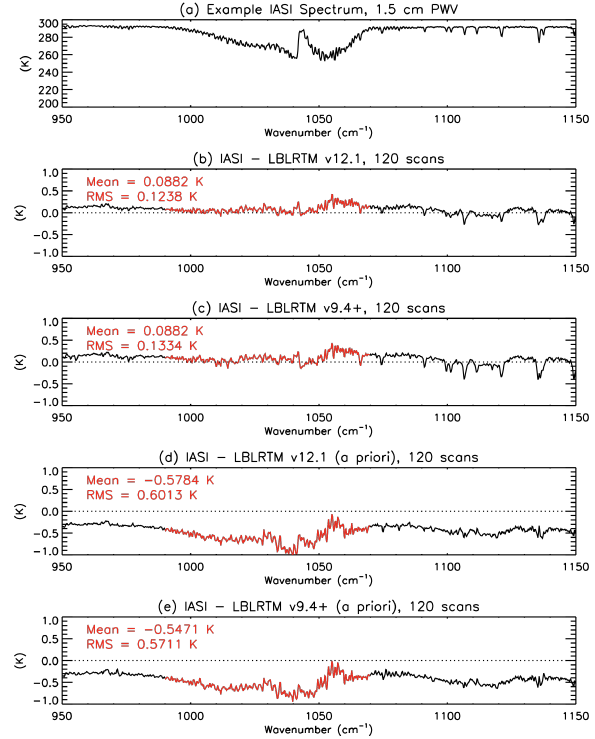
Fig. 26. (a) IASI-observed brightness temperature spectrum in the ν 3 band of O 3 for an example profile with 1.5cm PWV. (b) Mean of the final (a posteriori) brightness temperature residuals for 120 spectra using LBLRTM v12.1. (c) Mean of the final brightness tem- perature residuals for 120 spectra using LBLRTM v9.4 + . (d) Mean of the a priori brightness temperature residuals for 120 spectra us- ing LBLRTM v12.1. (e) Mean of the a priori brightness temperature residuals for 120 spectra using LBLRTM v9.4 + . The O 3 retrieval window is highlighted in red. Note that the RMS due to instrument noise alone in this retrieval window is